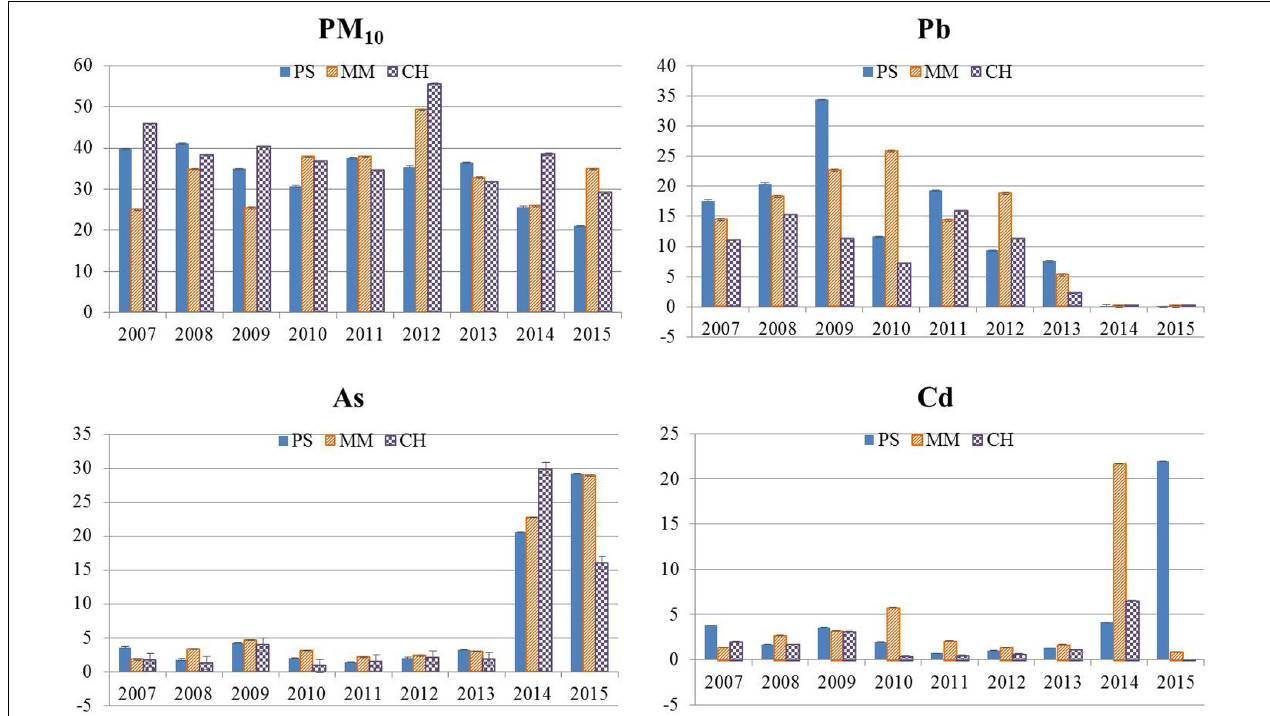
FIGURE 2 | Annual concentration of PM 10 ( µ g m − 3 ) and Pb, As, and Cd in PM 10 (ng m − 3 ) from 2007 to 2015.